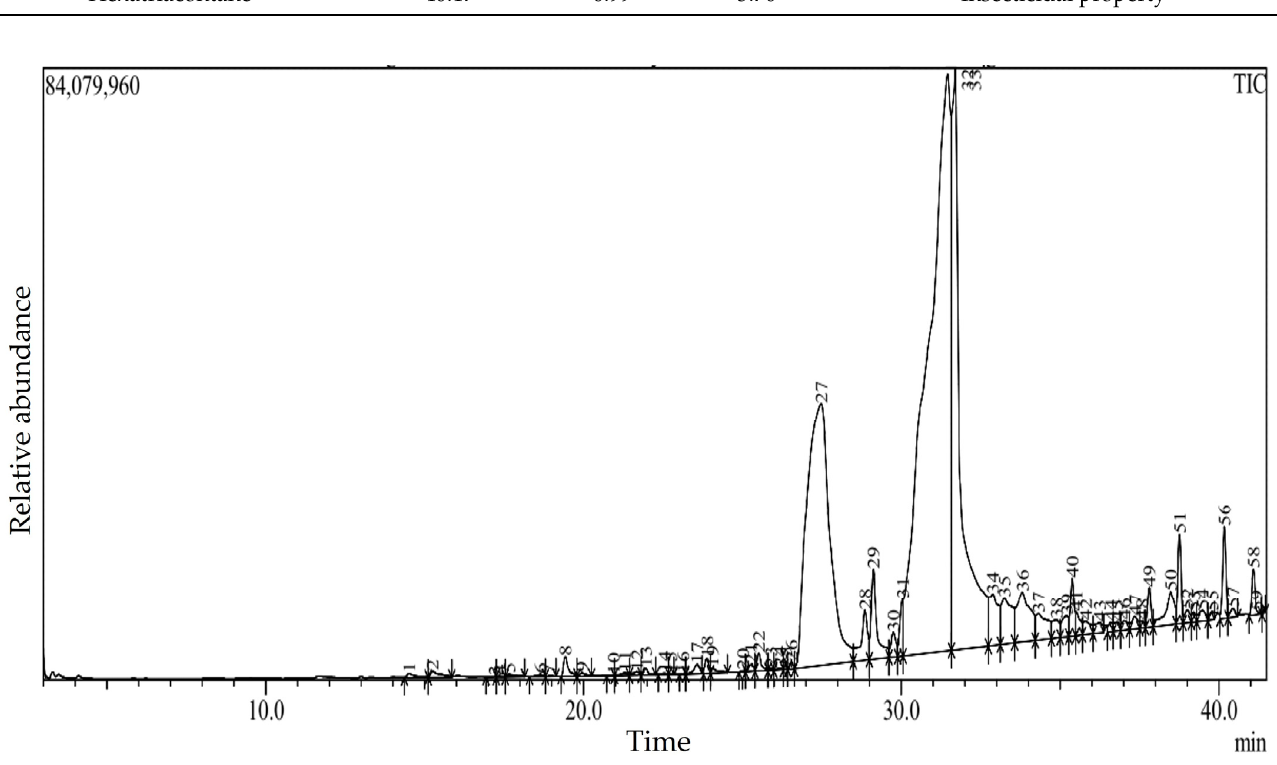
Figure 3. Chromatogram (peak identification and retention time) of 59 bioactive compounds of bitter apple ( C. colocynthis ).